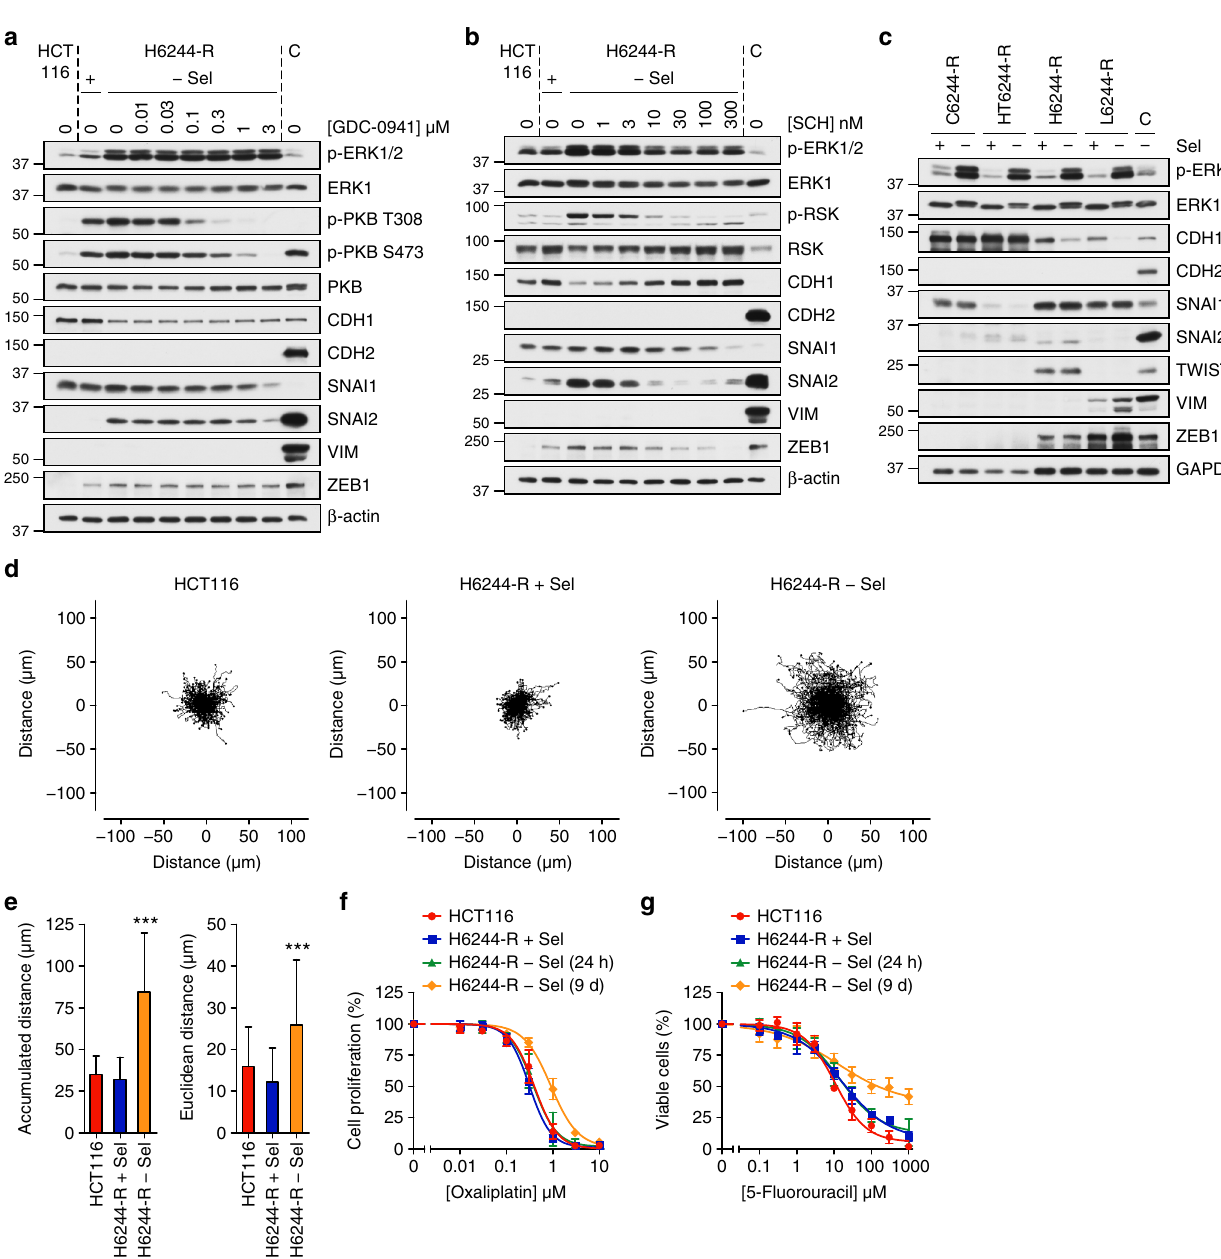
Fig. 9 EMT following MEKi withdrawal is ERK1/2-dependent and associated with enhanced cell motility and chemoresistance. a , b H6244-R cells were treated with the indicated concentrations of GDC-0941 ( a ) or SCH772984 (SCH) ( b ) in the absence of selumetinib ( − Sel) for 72 h. HCT116, and H6244-R cells treated with 2 μ M selumetinib ( + ), were included as controls. c C6244-R, HT644-R, H6244-R and L6244-R cells were treated with 1, 1, 2 and 4 µ M selumetinib (Sel, ( + )), respectively, or with DMSO only ( − ) for 72 h. a – c Lysates were western blotted with the indicated antibodies. Results are representative of at least two experiments giving equivalent results and A549 cells were used for positive control (C), except for SNAI2 (SW620 cells). d , e HCT116 and H6244-R cells were treated with 2 μ M selumetinib (H6244-R + Sel) or DMSO only (HCT116, H6244-R − Sel) for 9 days. Cell movements were then tracked every 10 min for 16 h. Spider diagrams of individual cell paths ( d ) are shown with averaged results ( e ) of mean accumulated and Euclidean distance ± SD ( n > 300 cells for each cell line). P < 0.001 (***) determined by one-way ANOVA with Tukey ’ s multiple comparisons test. f , g HCT116 and H6244-R cells were treated with 2 μ M selumetinib (H6244-R + Sel) or DMSO only (HCT116, H6244-R − Sel (9 d)) for 9 days. The following day, cells were treated as indicated with oxaliplatin for 24h ( f ) or 5- fl uorouracil for 72 h ( g ), maintaining prior presence or absence of selumetinib. As a control, H6244-R cells maintained in selumetinib throughout, were switched to selumetinib-free medium for the last 24h of oxaliplatin or 5- fl uorouracil treatment (H6244-R − Sel (24 h)). Cell proliferation was assayed by [ 3 H]thymidine incorporation ( f ) or cell viability assayed using Sytox Green ( g ). Results are mean ± SD of three independent experiments and normalized to control for each cell